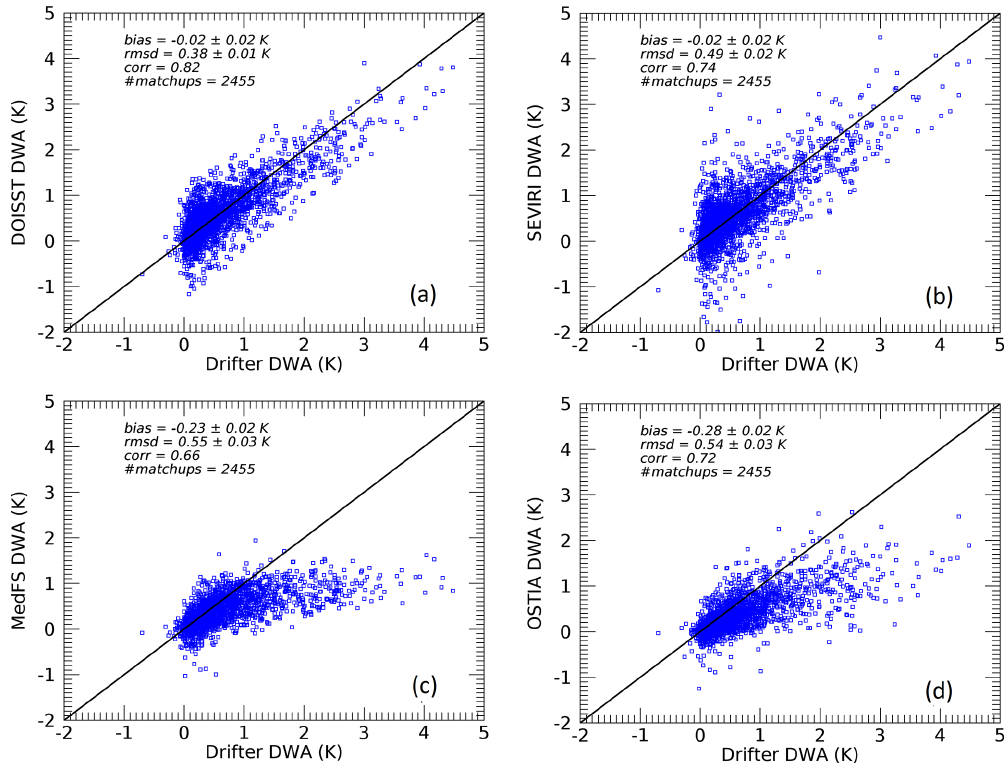
Figure 6. DWA scatterplots for (a) DOISST, (b) SEVIRI L3C, (c) MedFS, and (d) OSTIA diurnal vs. drifters over the period